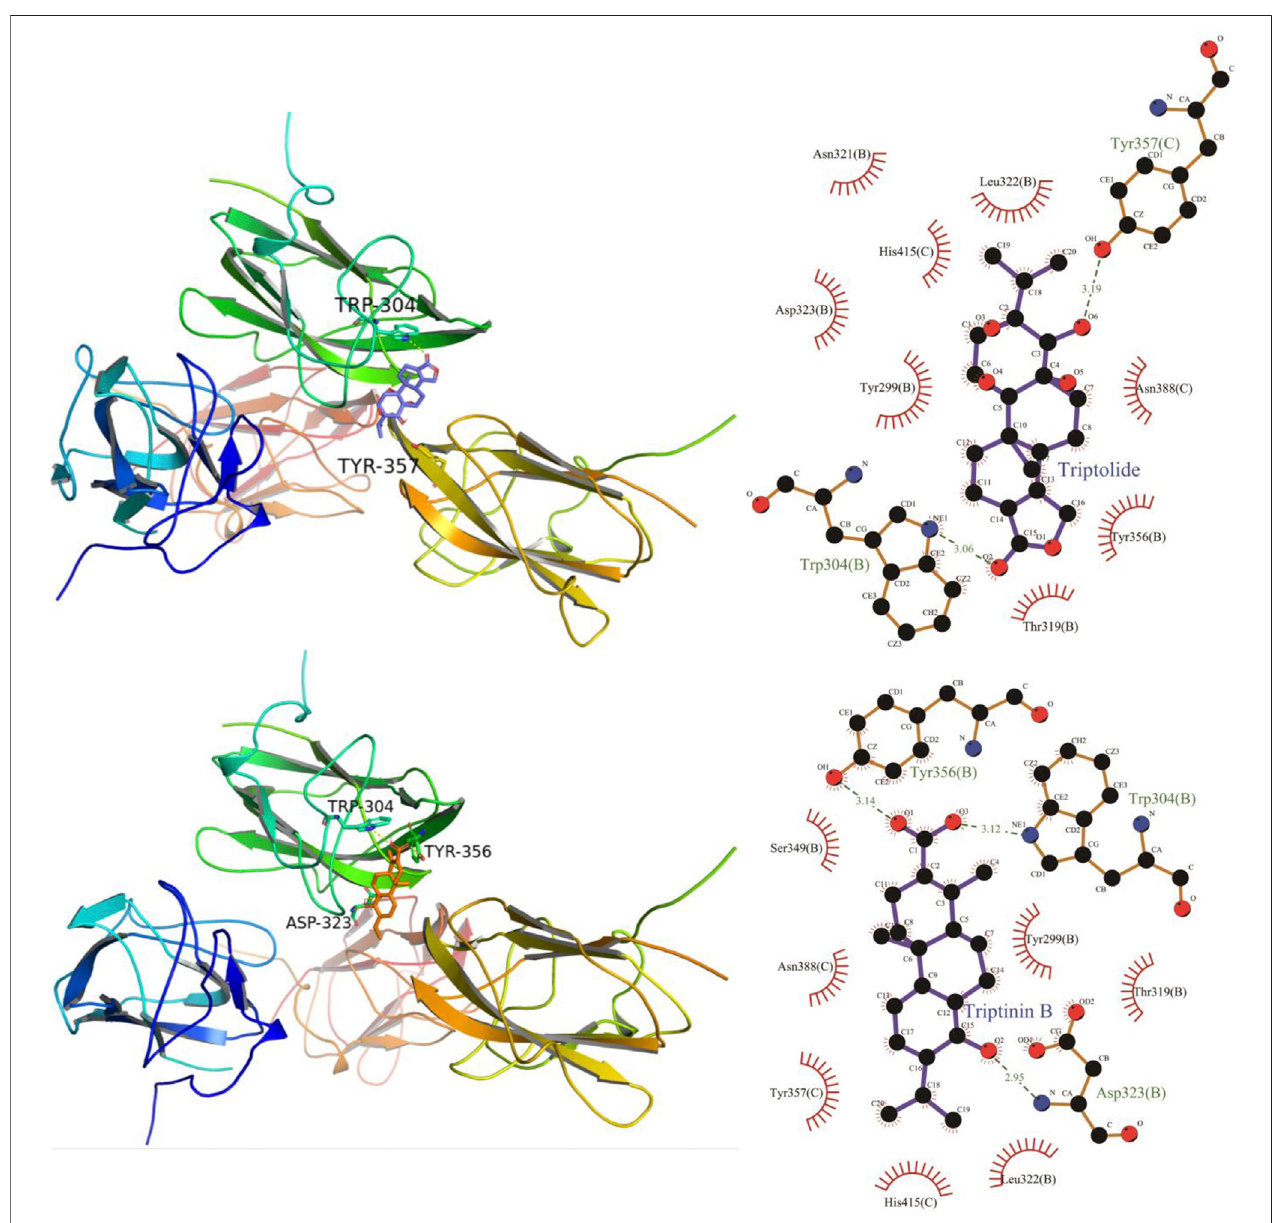
FIGURE 9 | Molecular docking diagram of TW core compounds and